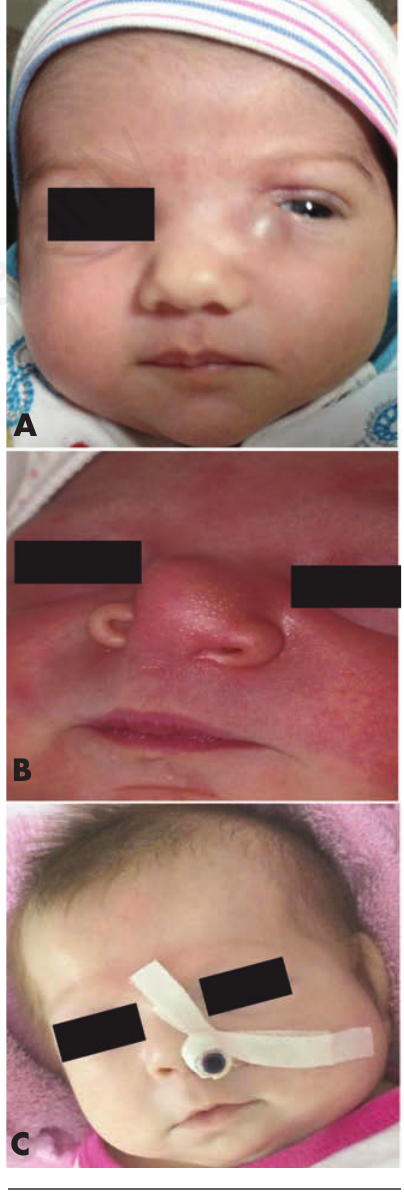
Figure 1. A) Redness swelling around left eye punctum; B) narrow and asymmetric nostrils, swelling with undefined borders on the nose; C) appearance of the patient with catheter